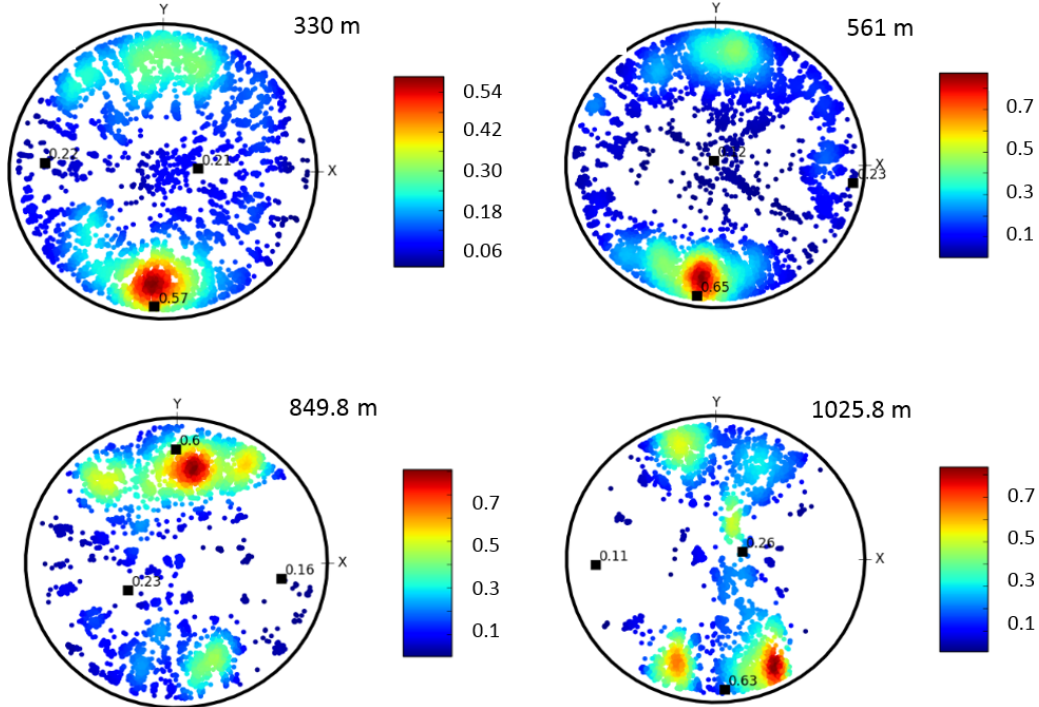
Figure 9. Fabric represented in stereographic projection/pole figure, projected into the vertical planes of the thin sections at depths of 330, 561, 849.8, and 1025.8m. The OY direction in the pole figure is approximately the vertical ice core axis. The center of the diagram corresponds to the approximate horizontal. Only 10000 data points randomly selected are plotted for each thin section. The color bars correspond to the density of plotted data points.